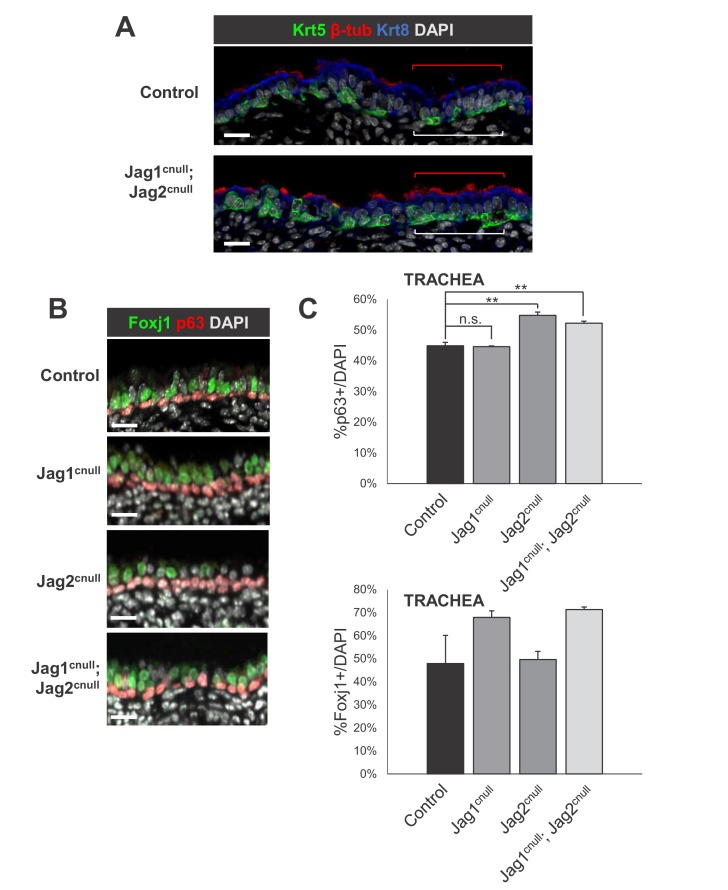
Loss of Jag ligands results in expansion of the embryonic basal cells and multiciliated cells in the E18.5 extrapulmonary airways (trachea).IF of basal cells (A: Krt5, B: p63) and multiciliated cells (A: beta-tubulin 4; B: Foxj1) in control and double Jag1cnull; Jag2cnull tracheas. (C) Morphometric analysis of basal cells (top: p63+) and multiciliated cells (bottom: Foxj1 +) in single and double Jag mutant tracheas. Sections of whole trachea were counted for p63+ and DAPI+ cells and the percentage of p63+ cells was determined in airway epithelium. Graphs are mean ± SEM; **p<0.05. Scale bars = 20 μm.